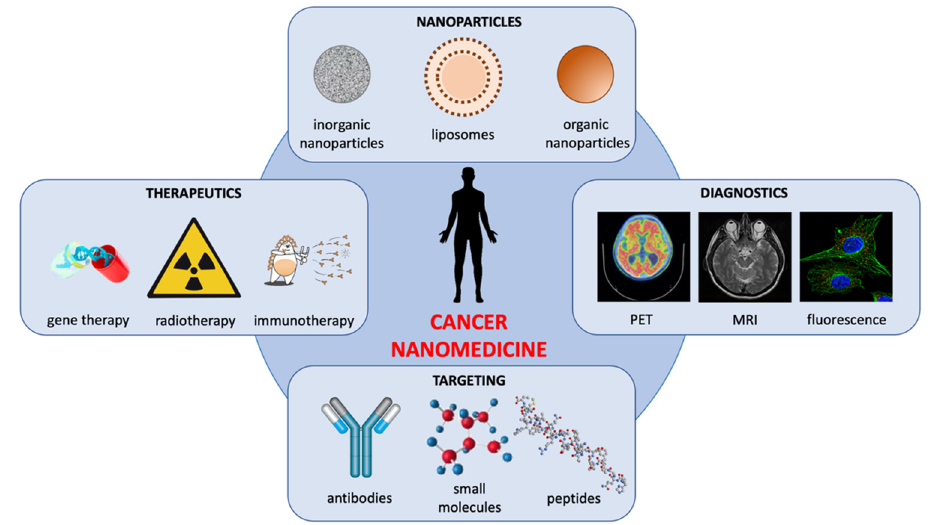
Figure 1. Nanodevices in imaging and therapies. The compatibility between nanoparticle size and the biological systems, coupled with the ability to tailor their physicochemical properties, enhances a personalized approach to disease management, and therapies could considerably improve the diagnostics and therapeutics of various cancers.